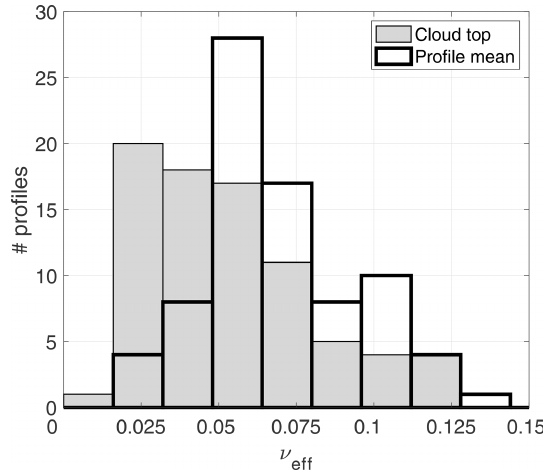
Figure 12. Histogram of computed effective variance ( ν eff ) assum- ing a modified gamma distribution for CDP values sampled near the cloud top (filled gray) and averaged throughout the cloud pro- file